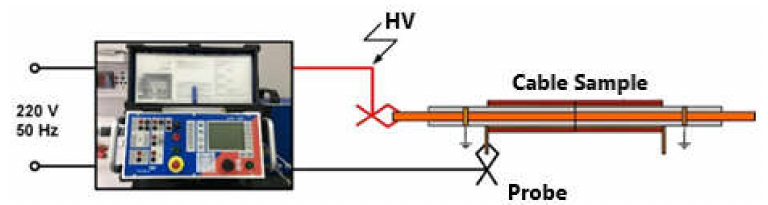
Figure 7. Omicron CPC100 / CPTD1 and connection diagram.